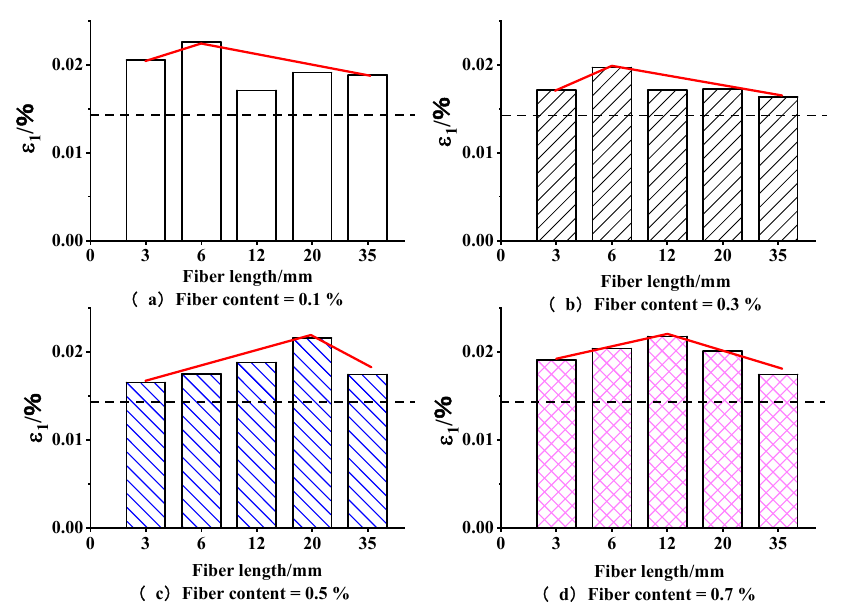
Figure 6. Variations in the damage strain with fiber length and different fiber contents. Considering the peak stress in the stress-strain curve as the peak strength ( σ max ) for analysis, Figure 7a–d illustrates the variations in the peak strength of the specimens with different fiber lengths and fiber contents. The dashed lines represent the cemented soil’s peak strengths without the addition of fibers. Figure 7 shows that the incorporation of basalt fibers can effectively increase the peak strengths of the specimens, and that the peak strengths of all of the specimens with fibers incorporated are greater than those of the specimens without fibers incorporated. The peak strength curves showed the tendency to decrease with an increase in the fiber length, except for a fiber content of 0.1%. The maximum peak strength values occurred in the case of the 3 mm fiber length, when the fiber contents were 0.3%, 0.5%, and 0.7%, and the 12 mm fiber length, when the fiber content was 0.1%. To sum up, the peak strength reached its maximum at a fiber content of 0.1% and a fiber length of 12 mm.